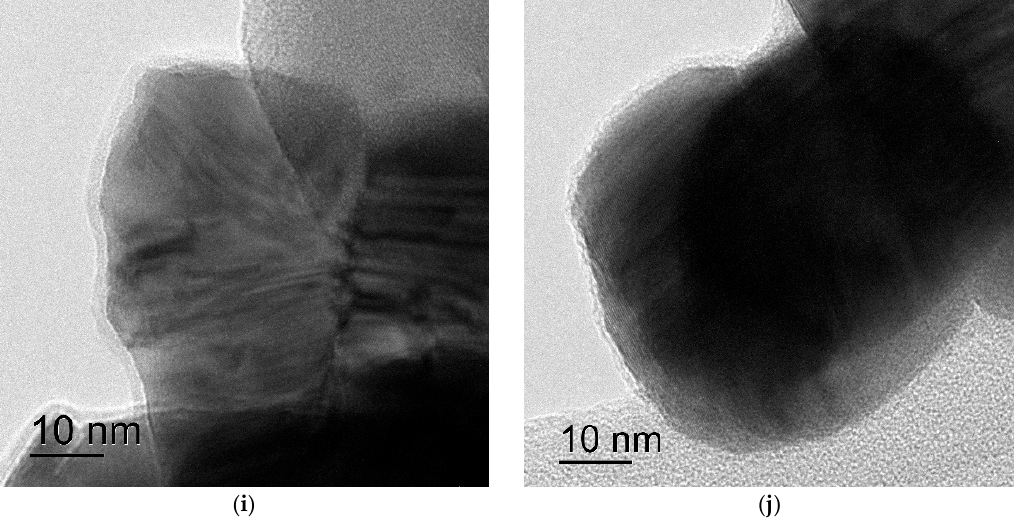
Figure 2. TEM micrographs of Na 1.2 Zr 1.9 Co 0.1 (PO 4 ) 3 ( a , b ) and Na 2 Zr 1.5 Co 0.5 (PO 4 ) 3 ( c – j ) powders.